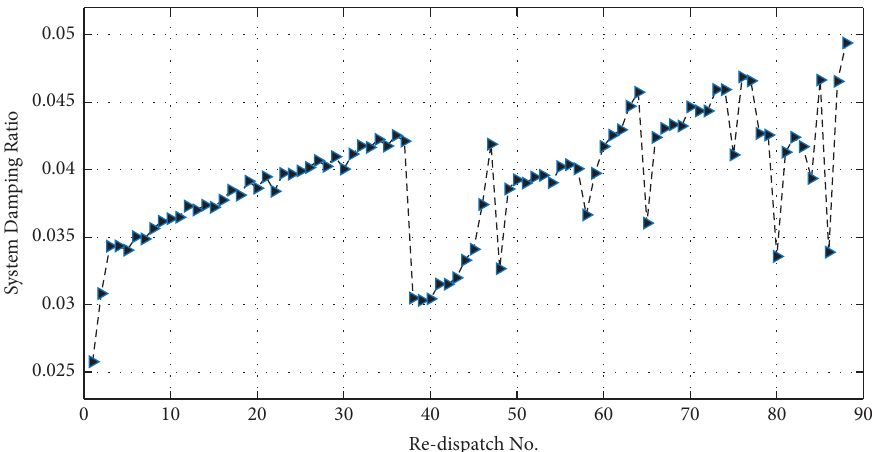
Figure 7: Trace of system damping ratio for IEEE 39-bus system.